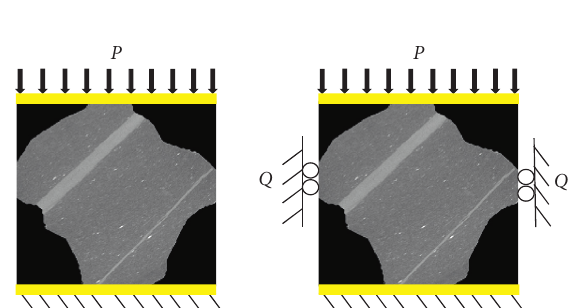
Figure 6: Mechanical loading diagram of the numerical